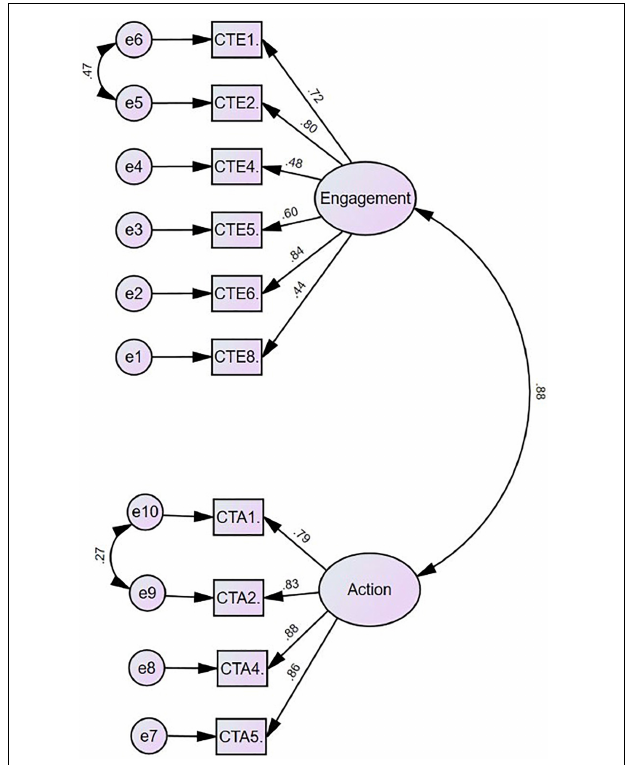
FIGURE 1 | CFA result of compassion for